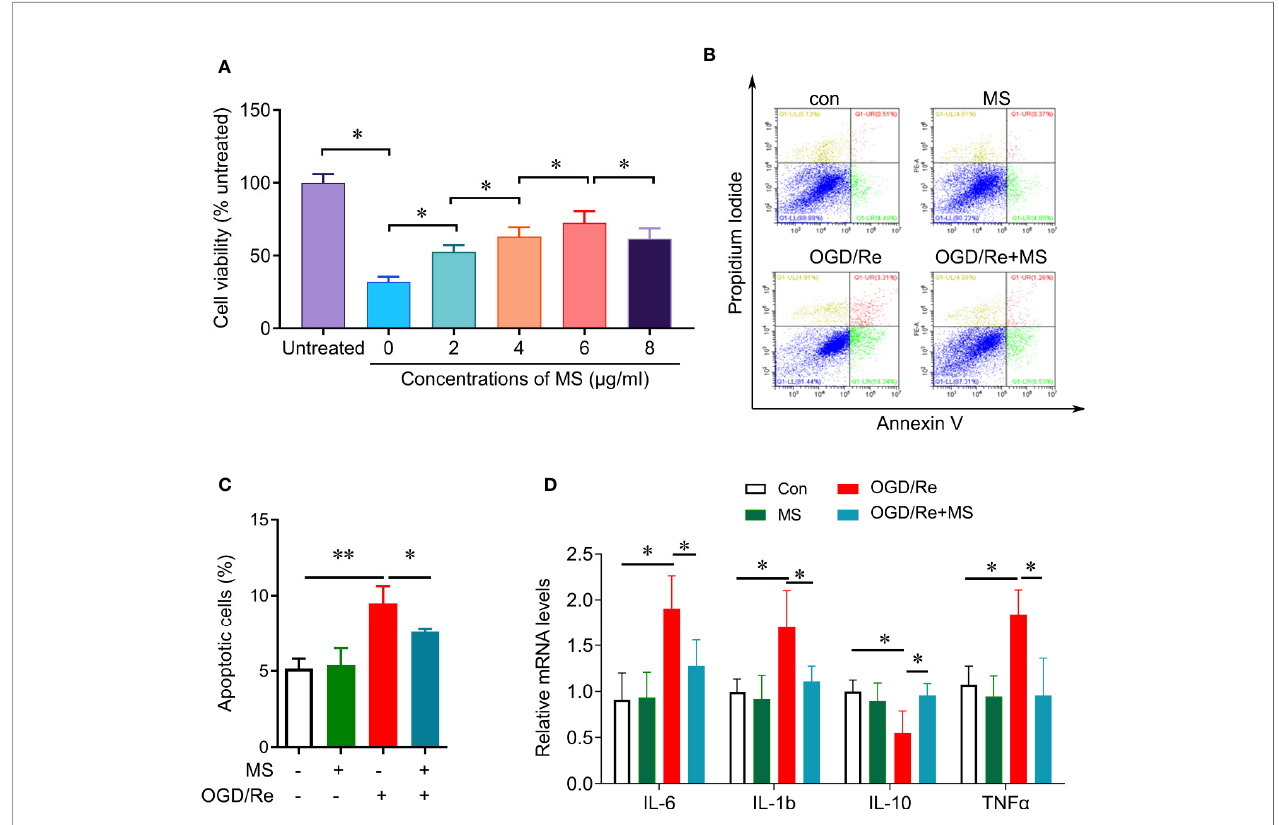
FIGURE 1 | Protective effect of Malva sylvestris L. against OGD/Re-induced injury on H9c2 cells. (A) CCK-8 was performed to determine the cell viability after indicated treatment in H9c2 cells. (B , C) Flow cytometry was performed to determine the apoptotic cell after indicated treatment in H9c2 cells (B) , and quanti fi cation (C) . (D) qPCR was performed to determine the mRNA expression of IL-6, TNF- a , IL-1 b , and IL-10 after indicated treatment in H9c2 cells. *p < 0.05 and **p < 0.01. MS, Malva sylvestris L. ; OGD/Re, oxygen glucose